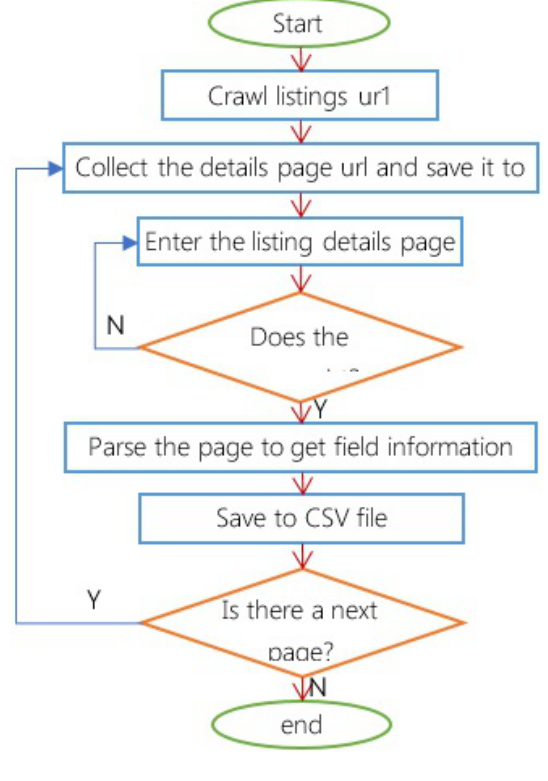
Fig. 1 The specific process of the